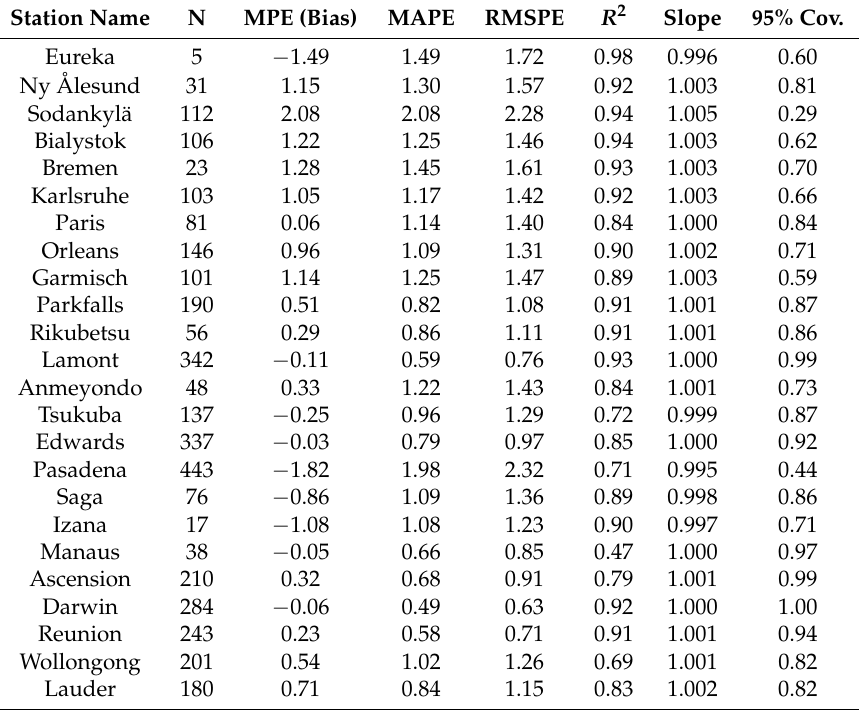
Table A1. Summary statistics of the differences between the fixed rank kriging Version 7r product predictions and the Total Carbon Column Observing Network measurements between 1 October 2014 and 28 February 2017. Summary statistics include the mean prediction error (MPE), the mean absolute prediction error (MAPE), the root-mean-squared prediction error (RMSPE), the coefficient of determination ( R 2 ), the slope (Slope) of the regression line constrained to pass through (0,0) and the empirical 95% coverage (95% Cov.). The number of observations considered in each row is denoted as N